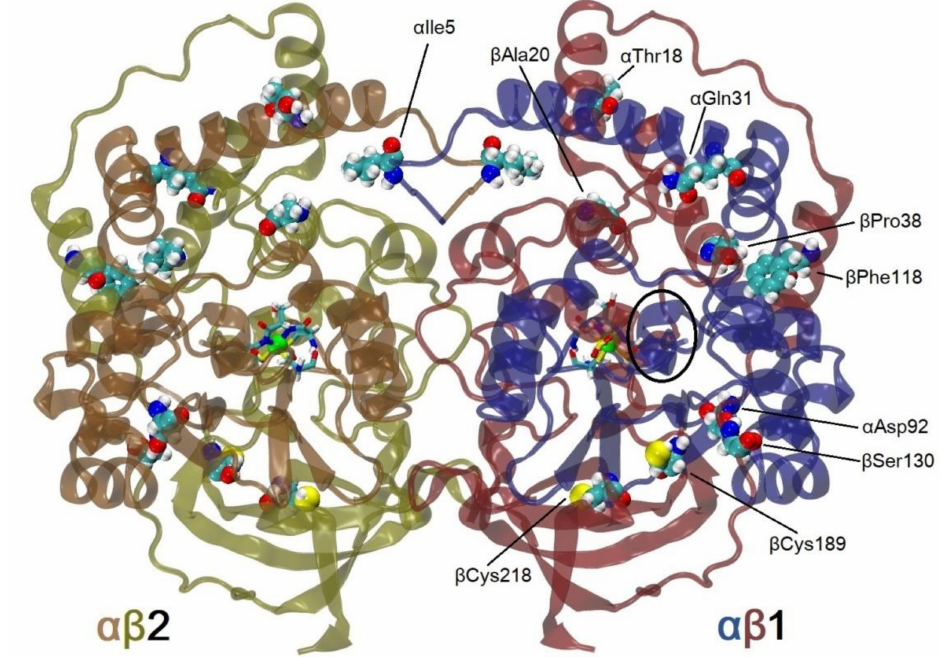
Figure 1. Structure of wild-type (WT) Pseudonocardia thermophila JCM3095 (PtNHase; PDB code: 1IRE) tetramer (biological assembly 1) with highlighted active site (licorice style), cobalt ion (green sphere), and 10 amino acids (vdW spheres) studied in this research. Blue and orange correspond to α subunit, red and yellow to β subunit. The αβ 1 subunit present in the PDB file is shown in blue and red; subunit αβ 2 from the biological assembly is shown in orange and yellow. In black ellipse, β 178-184 α -helix is